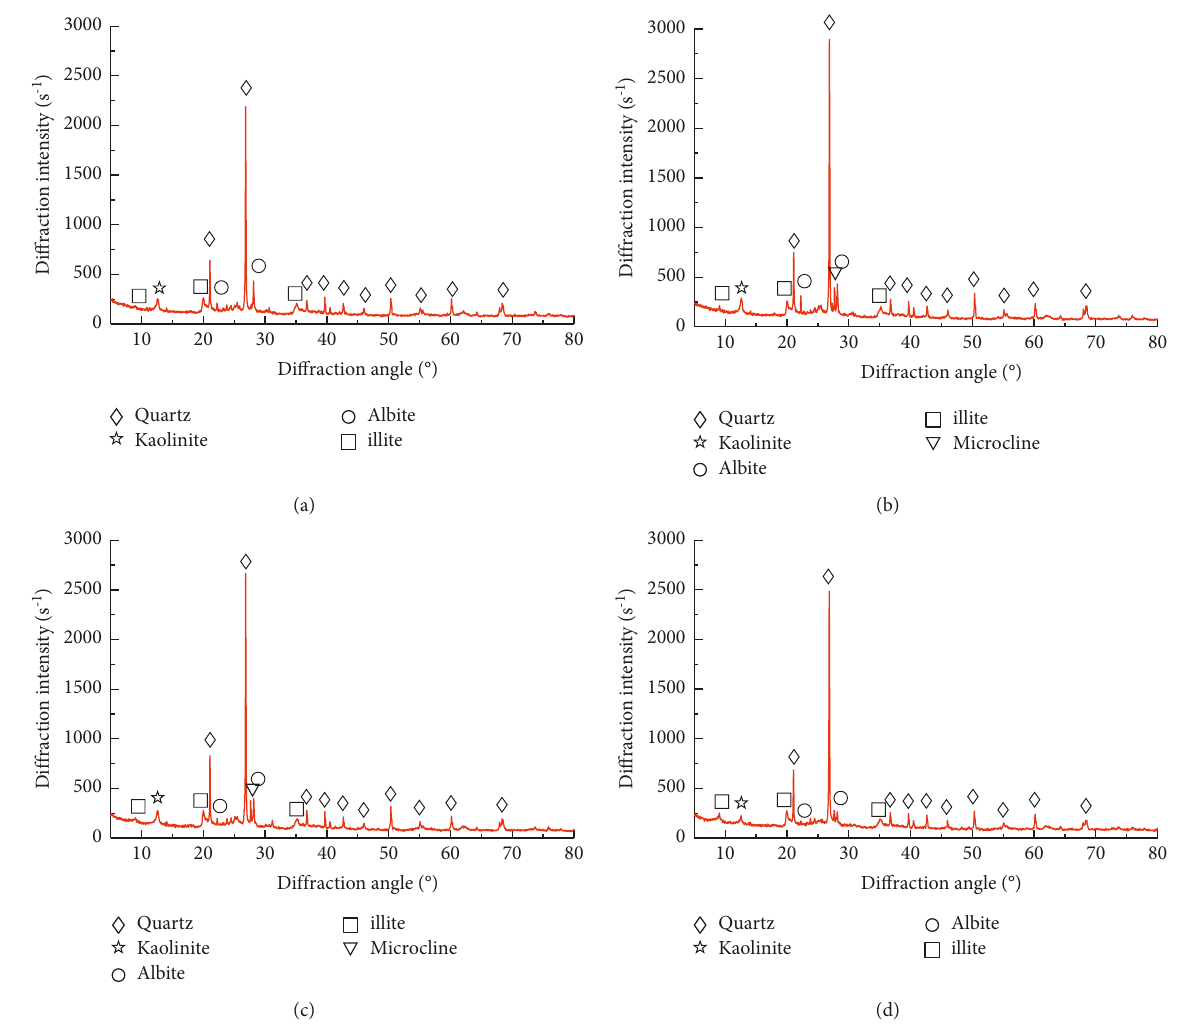
Figure 6: Typical XRD pattern after different temperatures: (a) 25 ° C, (b) 200 ° C, (c) 300 ° C, and (d) 500 °